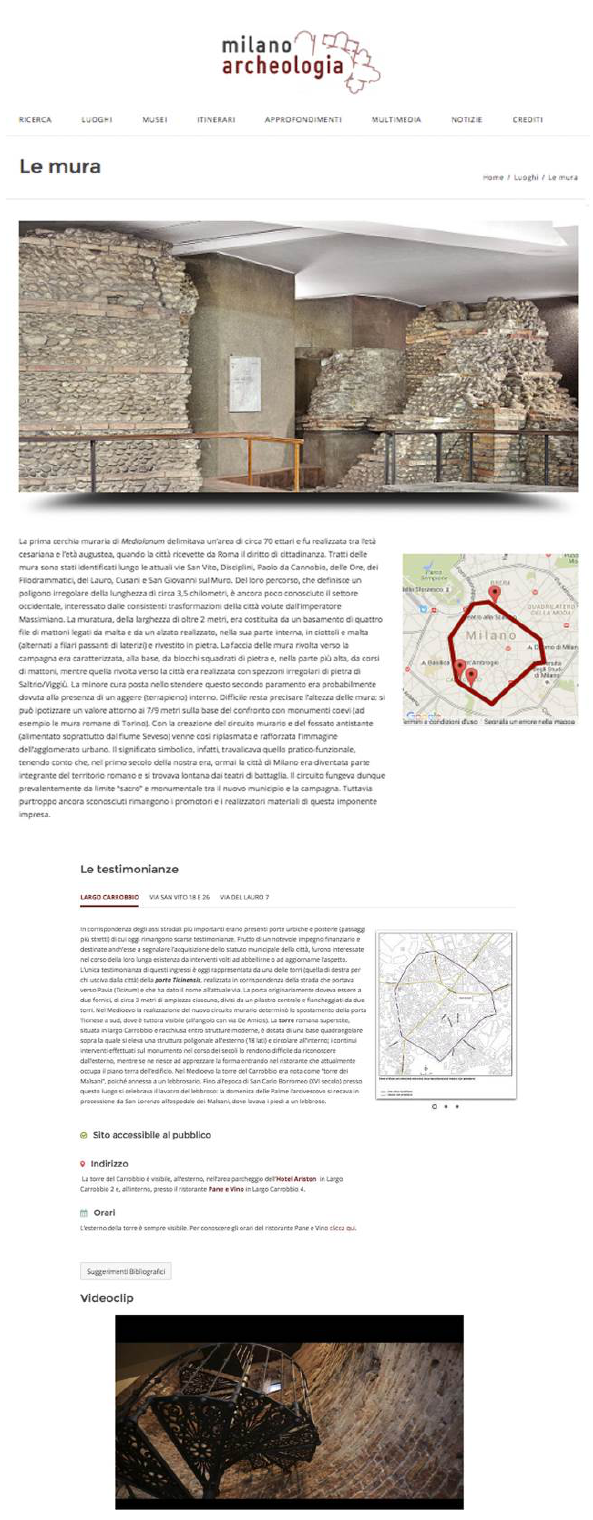
Figure 3. Example of the web page about the monumental complex of the “walls” in Milan to make virtually accessible sites actually not open to the public and to return the suggestion of the spiritus loci through an emotional language, thus contributing to recompose the unity of